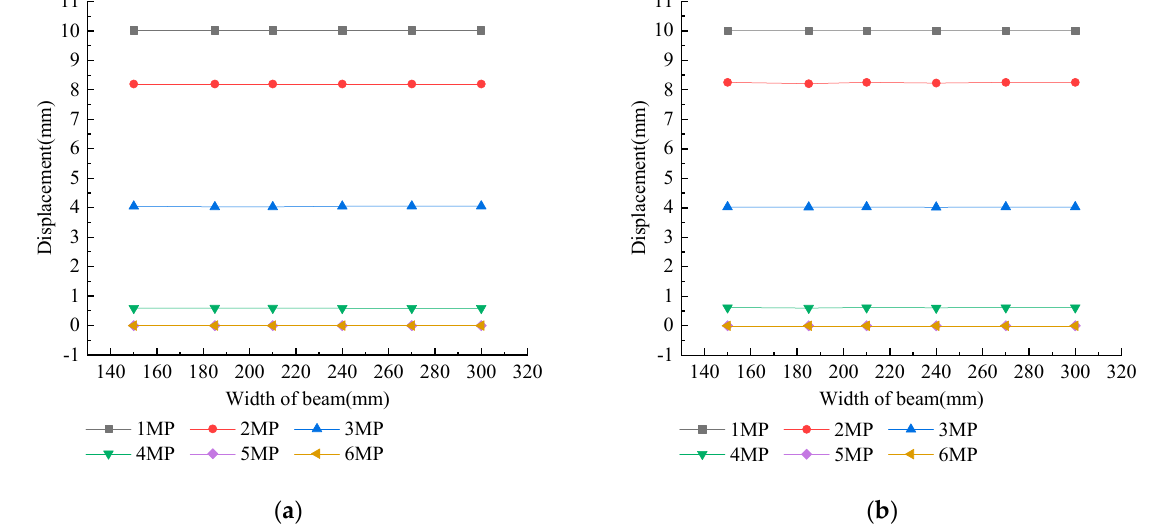
Figure 12. The vertical displacement trend of the rail seats and the bottom of the cast-in-place concrete under the conditions of different beam widths during the running period. ( a ) Rail seats and ( b ) cast-in-place concrete.